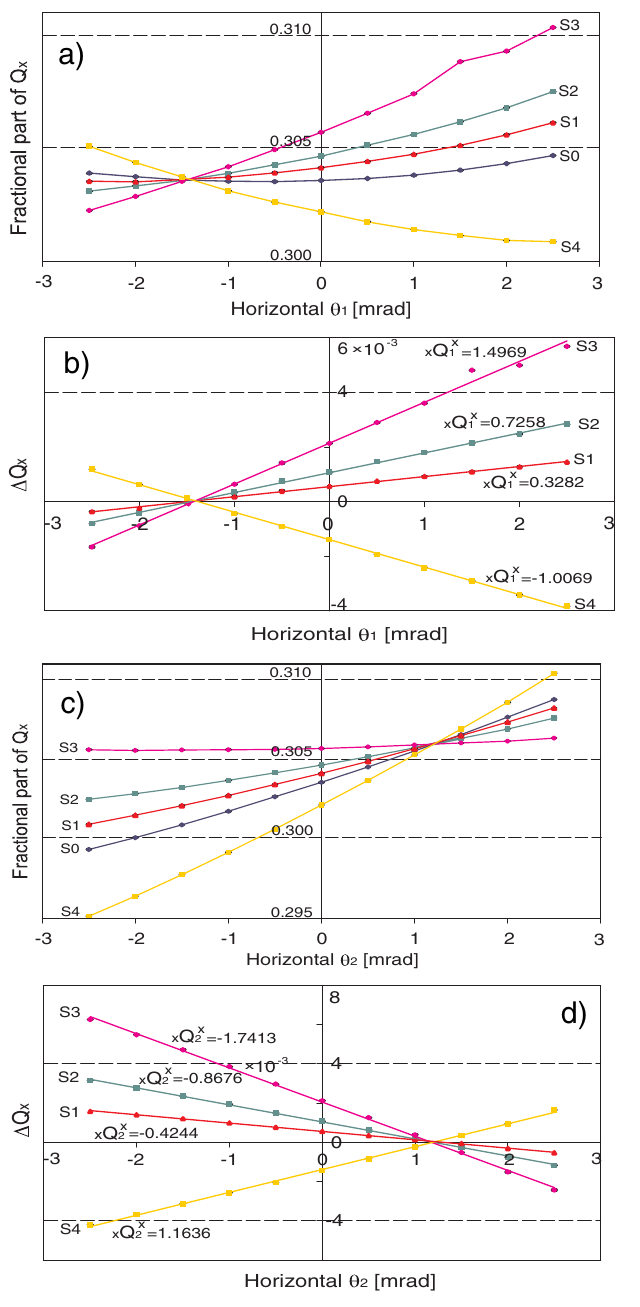
FIG. 6. (Color) Measured tune response for several strengths of the normal error deforming the closed orbit with the first steerer (a) and difference tune response (b). In (c) and (d) the same quantities are obtained varying the second steerer.